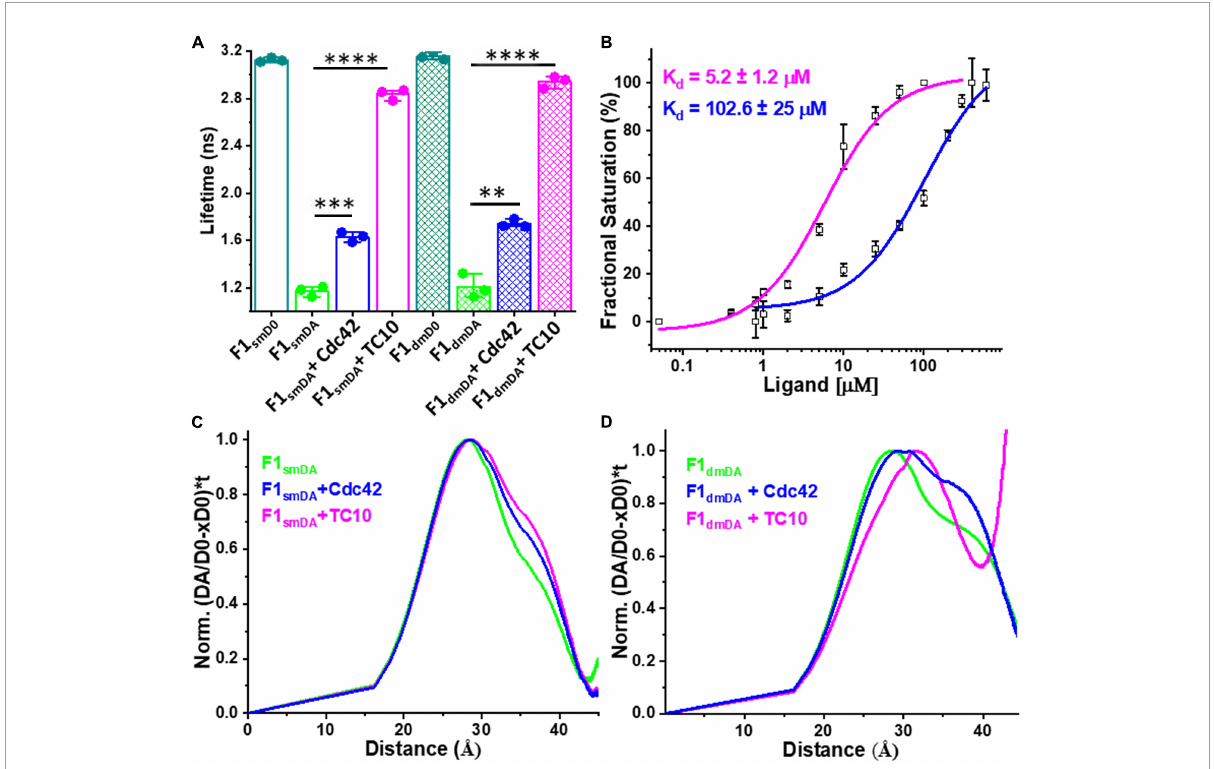
FIGURE4 Interactions of open state mutant sensors with Cdc42 and TC10. (A) Bar plot depicting the species-weighted CFP (cid:104) τ (cid:105) of the CB wild-type, open state single mutant (sm) and double mutant (dm) FRET sensors (F1 smD 0 and F1 dmD 0 ), their FlAsH-labeled counterparts (F1 smDA and F1 dmDA ) and the FlAsH labeled sensors in the presence of Cdc42 or TC10. ∗∗ P < 0.01, ∗∗∗ P < 0.001, ∗∗∗∗ P < 0.0001. (B) F1 dmDA binding affinity (K d ) plots for TC10 (magenta) and Cdc42 (blue). TC10 and Cdc42 binding affinity for the F1 dmDA were measured as 5.2 ± 1.2 µ M and 102 ± 25 µ M, respectively. Data from three individual biological replicates ( n = 3) are presented as mean values ± SD. (C,D) Model-free distance distribution fits for the inter-fluorophore distance corresponding to the time-resolved CFP fluorescence intensities (Equations 12, 13). Normalized distance distribution curves shown for F1 smDA (C) and F1 dmDA (D) in the absence (green) and presence of TC10 (magenta) and Cdc42